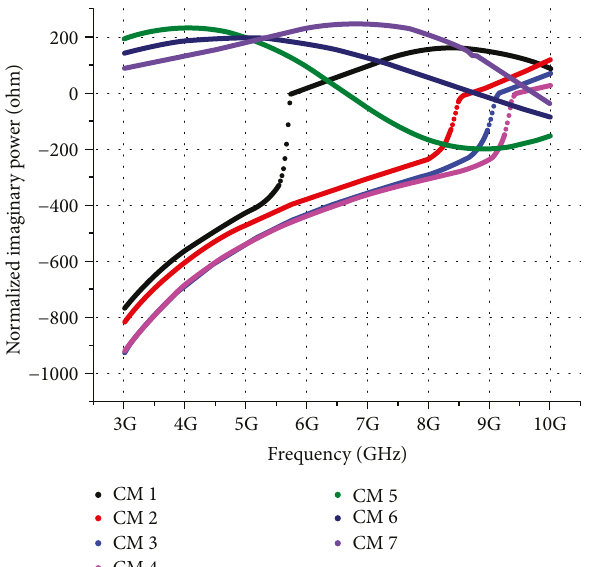
Figure 11: The normalized imaginary powers corresponding to the CMs shown in Figures 10(a) and 10(b).